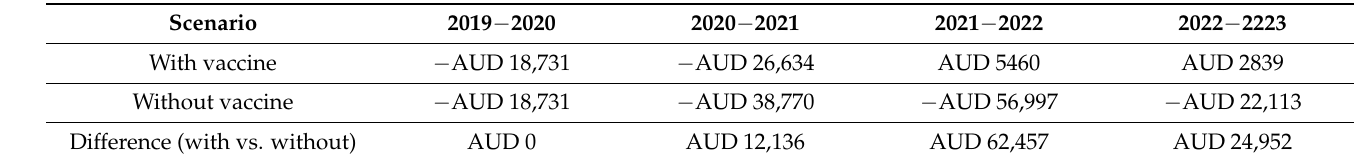
Table A7. Impacts on Commonwealth Govt budget (Financial year, AUD m changes)—Revenue— with and without vaccine vs. no COVID scenario.